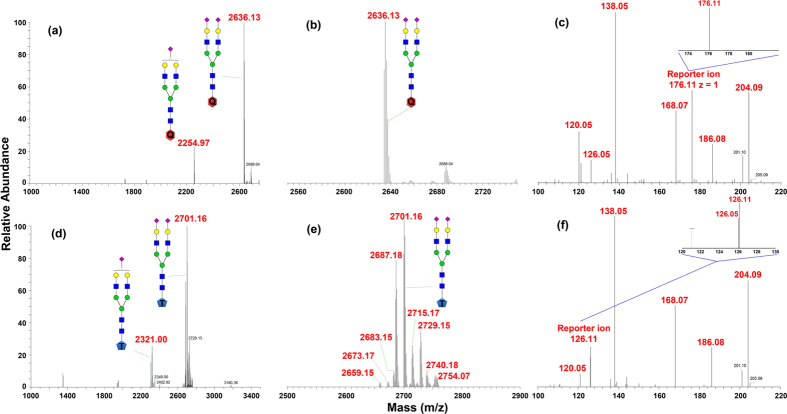
Comparison of N-glycan labeling by QUANTITY and aminoxyTMT-126 (TMT).Standard sialylglycopeptide (SGP) was used for labeling via reduction amination (1M NaCHBH3, DMSO:HOAc = 7:3, 65 °C/4h). SGP has two sialic acids including N2H2S and N2H2S2. (a) Full MS spectrum of SGP-QUANTITY. (b) MS1 spectrum of N2H2S2-QUANTITY. (c) MS2 reporter ions of N2H2S2-QUANTITY. (d) Full MS spectrum of SGP-TMT. (e) MS1 spectrum of N2H2S2-TMT, several by-products observed after aminoxyTMT labeling. (f) MS2 reporter ions of N2H2S2-TMT.